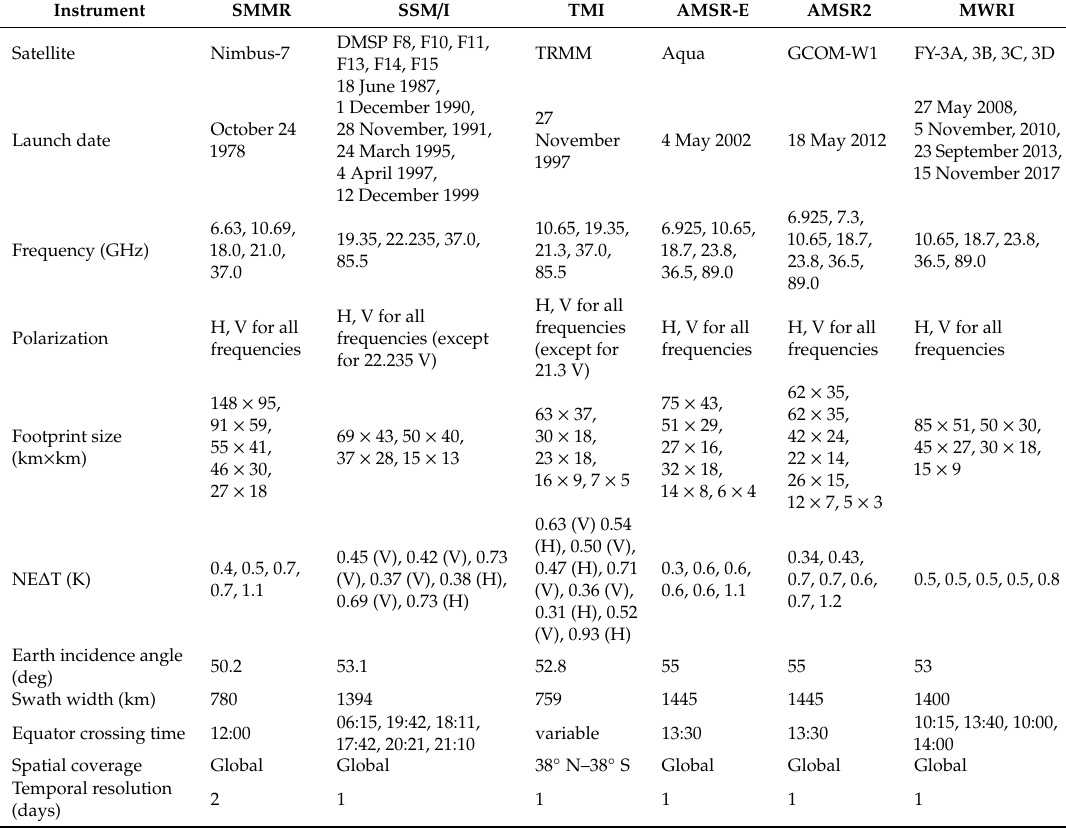
Table 1. Performance characteristics of PMW satellite